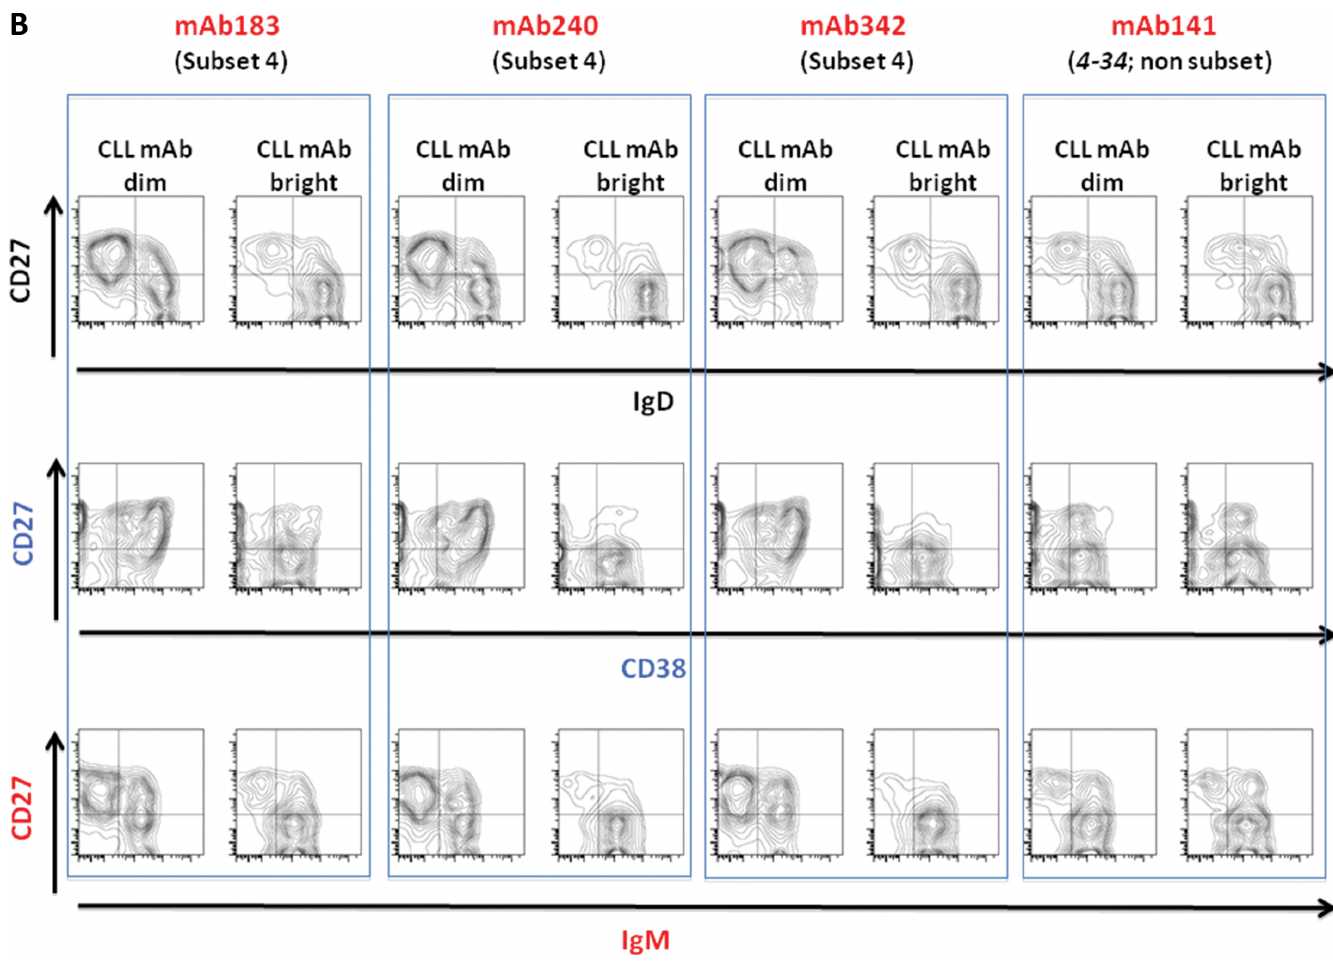
CLL Subset 4 IGs Do Not Bind DNa or Other Intracellular autoantigens Next, we tested the reactivity of sub- set 4 mAbs with nuclear and cytoplas- mic autoantigens by exposing the three CLL mAbs to HEp-2 cells and detecting binding using goat anti-human IgG pAbs conjugated with a fluorochrome.